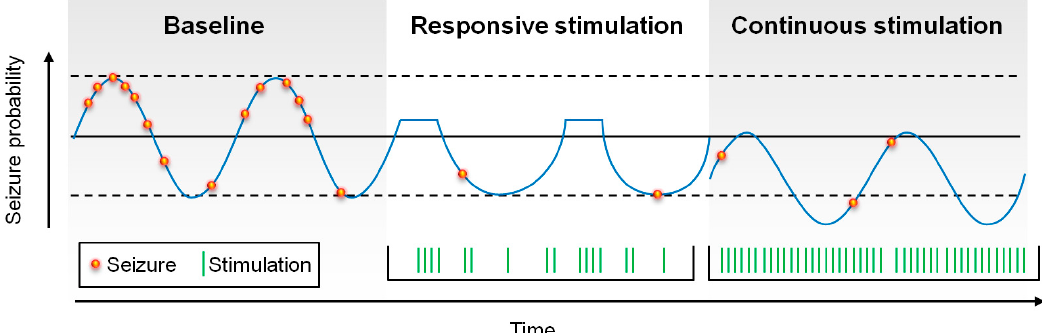
Figure 2. Schematic of the possible affects upon seizure probability by responsive and continuous stimulation. Responsive stimulation may abort seizures in real time, reducing the time in which the patient is at high-risk for seizures, whereas continuous stimulation may “shift” seizure probability down by modulating broader epileptogenic networks.